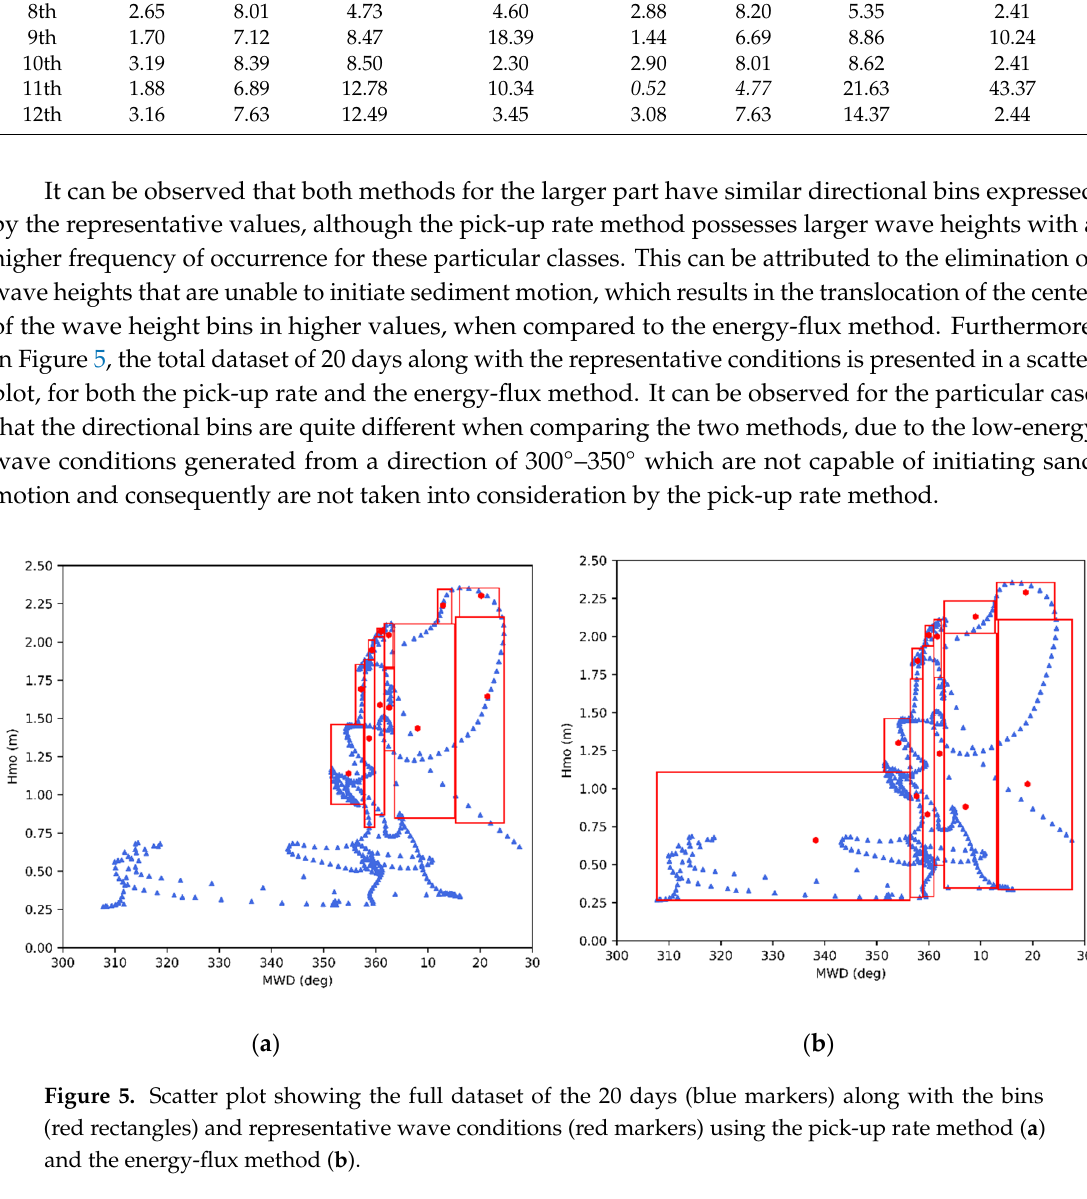
Table 1. Representative wave conditions from the time series of 7 days, using the pick-up rate and the energy-flux wave schematization methods.